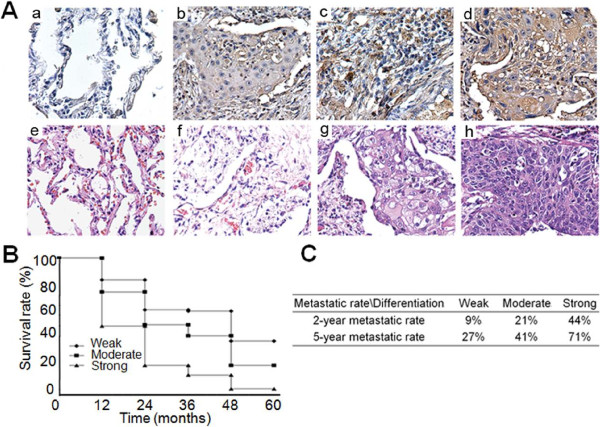
IHC analysis of CTSB expression in lung SCC and adjacent normal tissues. (A) Staining against CTSB showed significant differences between lung SCC and adjacent normal tissues, and overexpression of CTSB was likely to present with bad differentiation. IHC (a: adjacent normal tissues; b: well differentiated, weakly positive; c: moderately differentiated, moderately positive; d: poorly differentiated, strongly positive.); H & E (e: adjacent normal tissues; f: well differentiated; g: moderately differentiated; h: poorly differentiated). (B) Kaplan-Meier curves and statistics showed the correlation between CTSB expression and decreased survival. The 5-year survival rates were 41%, 20% and 2% for weak, moderate and strong staining samples, respectively, when CTSB was assessed as a marker (Statistical difference: weak VS moderate: P = 0.041; weak VS strong: P = 0.009; moderate VS strong: P = 0.021). Multivariate analyses using Cox proportional hazard model also showed that CTSB could also be developed as a prognostic factor for lung SCC. (C) Patient data showed the 2-year metastatic rates were 9%, 21% and 44% for weak, moderate and strong staining samples; the 5-year metastatic rates were 27%, 41% and 71% for weak, moderate and strong staining samples, respectively, when CTSB was assessed as a marker. Therefore, CTSB expression might affect metastatic capacity of lung SCC.